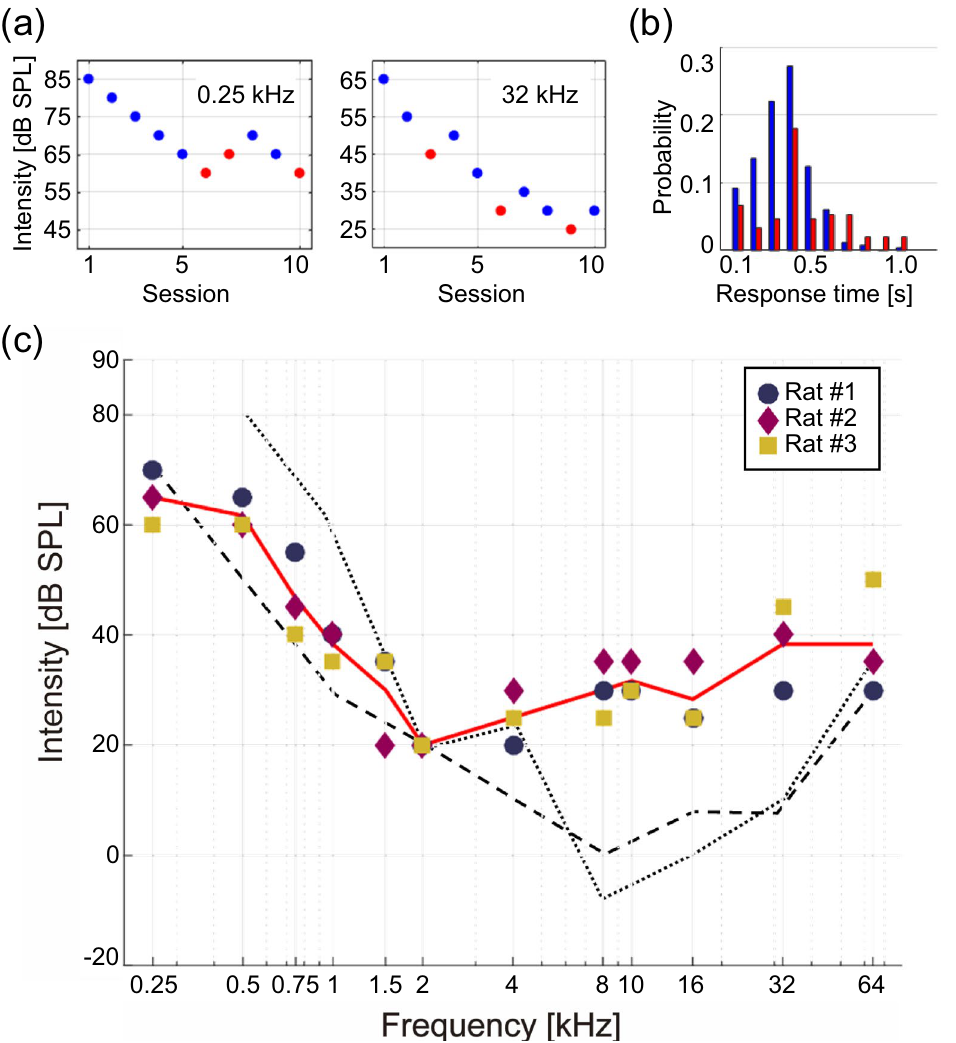
Figure 2. Results of pure-tone audiometry. ( a ) The transitions of test SPL values across sessions for 0.25 and 32 kHz tones. When the subject was rewarded in ≥ 6 out of 10 trials in a given assessment session, the test SPL was lowered in the next assessment session (blue); otherwise, the test SPL was increased in the next session (red). The detection of tone was defined as a success rate of 0.7. ( b ) Probability distribution of reaction times across 4 hearing tests with 4, 8, 16, and 32 kHz tones. The reaction times for successful (blue) and failed (red) trials are shown. Cases when the lever was not pulled into the backward state within 1 s after the sound presentation are not shown. ( c ) Estimated audiograms of animals. A red line indicates the average of all the audiograms. Dashed lines indicate the audiograms of Sprague–Dawley rats 10 (longer-dashed line) and cotton rats 9 (shorter-dashed line) reported in previous studies. Both lines were determined by subjective hearing tests.